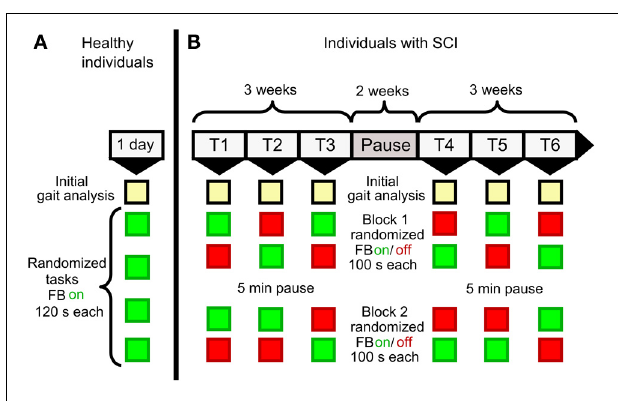
calculated in real-time during every step and compared to reference values. The calculated norm distance value is fed back to the participant using a projector and canvas.